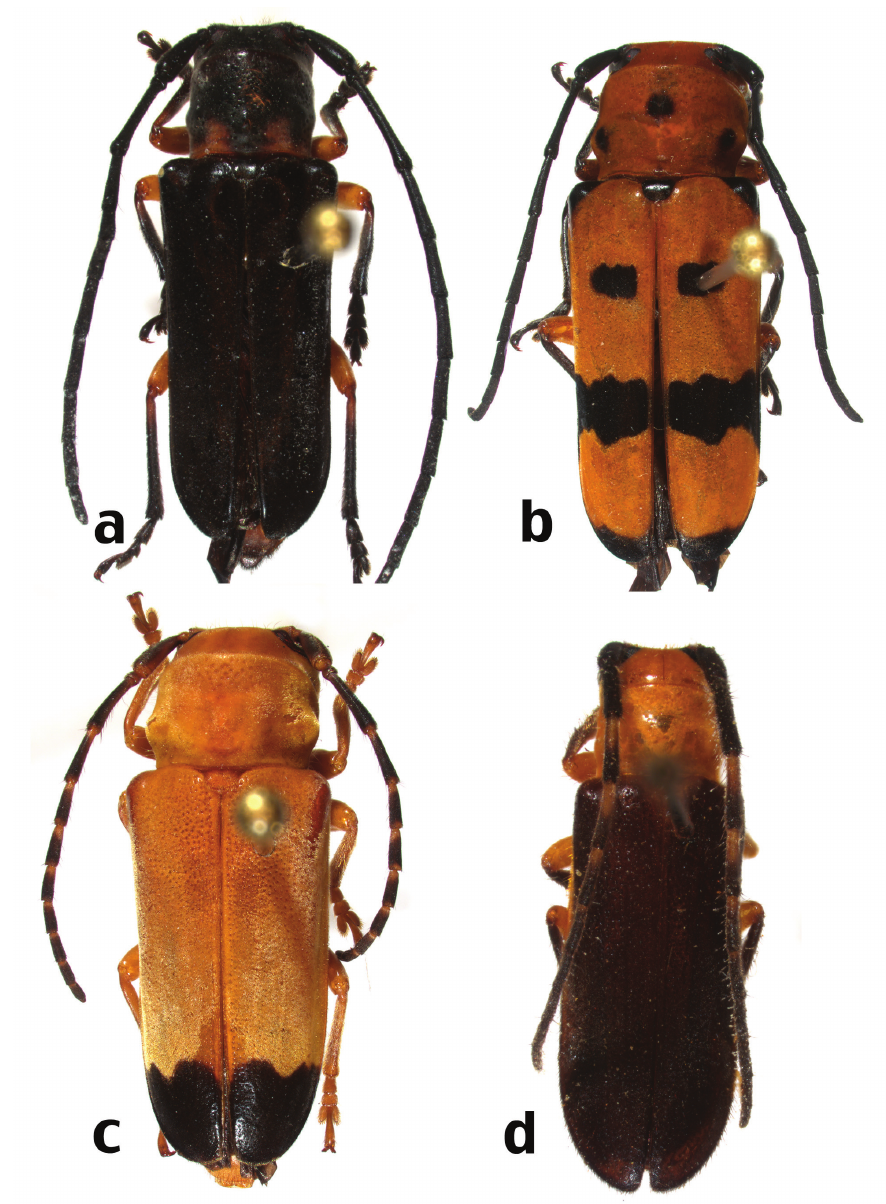
Figure 8. Dorsal habitus of Calocosmus species (not to scale): a C. janus Bates b C. magnificus Fisher c C. melanurus Gahan d C. nigripennis Chevrolat. Guerrero (1 specimen, USNM); Dominican Republic, Pedernales Province, 25 km N. Cabo Rojo, 18°06.769'N, 71°37.245'W, 679 m, Kelvin Guerrero (1 specimen, USNM); Dominican Republic: Pedernales, Sierra de Baoruco, Aceitillar, 23.6 km